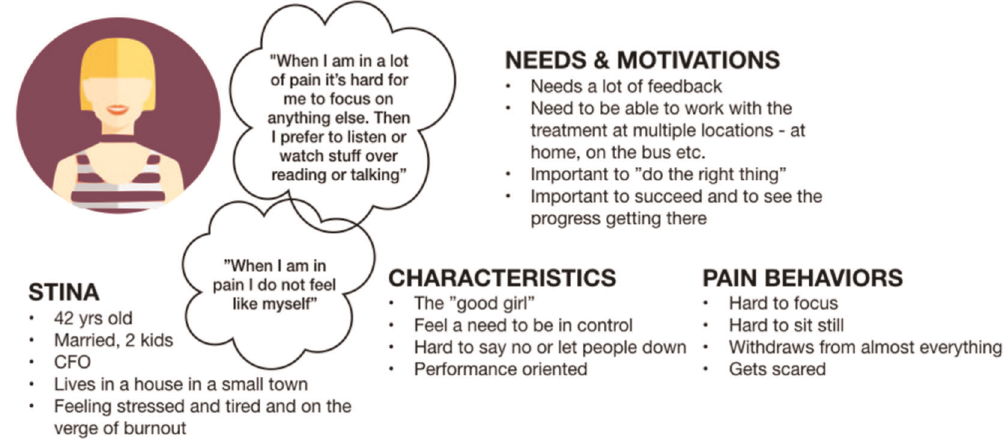
Fig. 1 Persona generated after multiple initial end-user interviews (translated from Swedish to